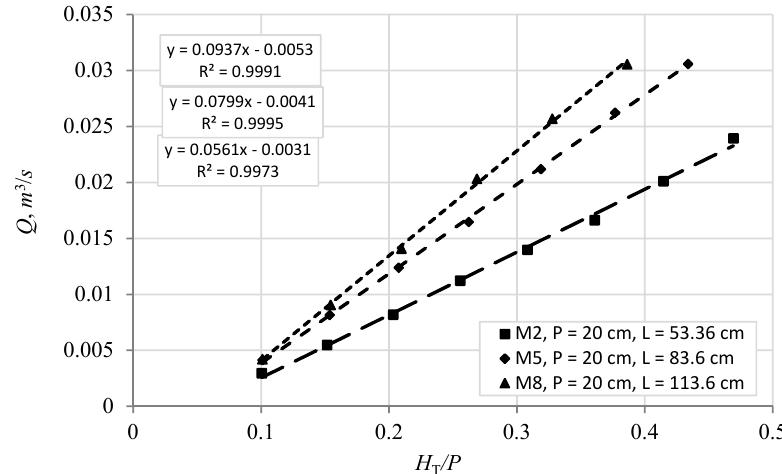
Figure 18. Total discharge, Q , vs. H T / P for models M2, M5, and M8